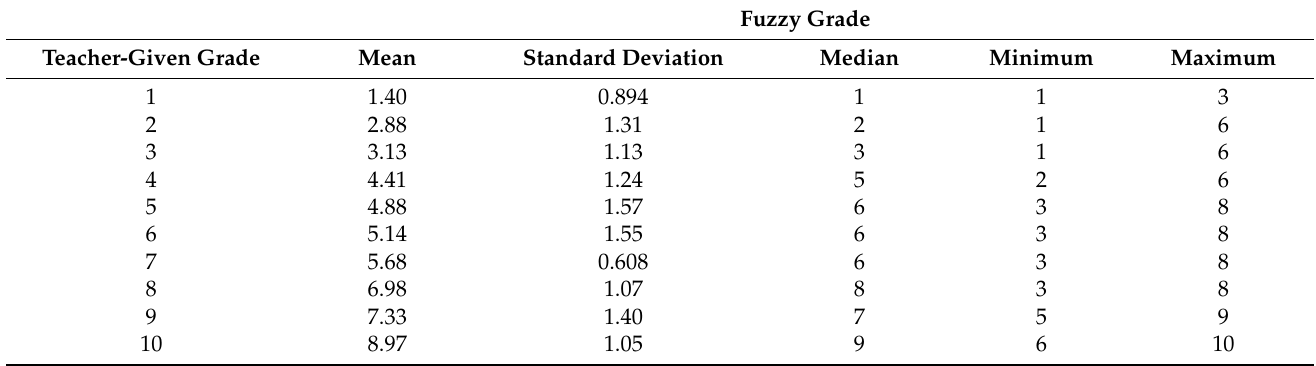
Table 14. Descriptive statistics for fuzzy grades among the levels of teacher-given